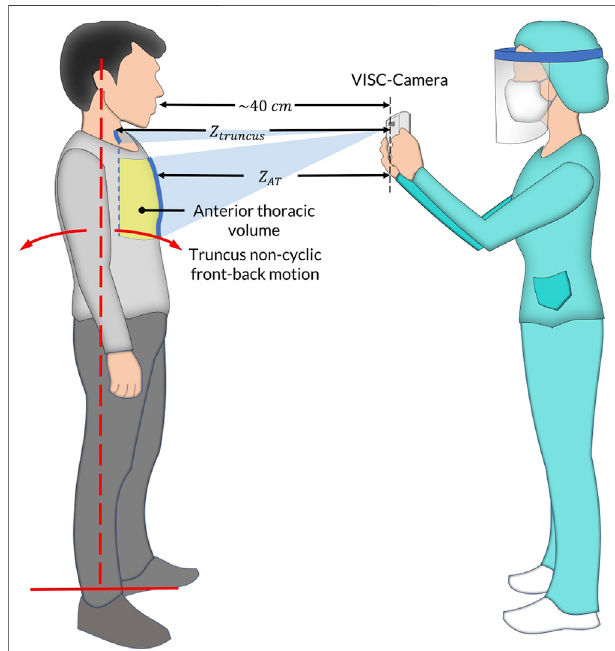
FIGURE 1 | The vital-signs-based infection screening composite-type camera (VISC-Camera) measurement setup in the standing position. In addition to respiratory anterior thorax ( Z AT ) region of interest (ROI) tracking algorithms, the VISC-Camera incorporates a non-respiratory truncus motion (red dotted line) removal algorithm (TMRA) using Z truncus movements determined as neck motions.